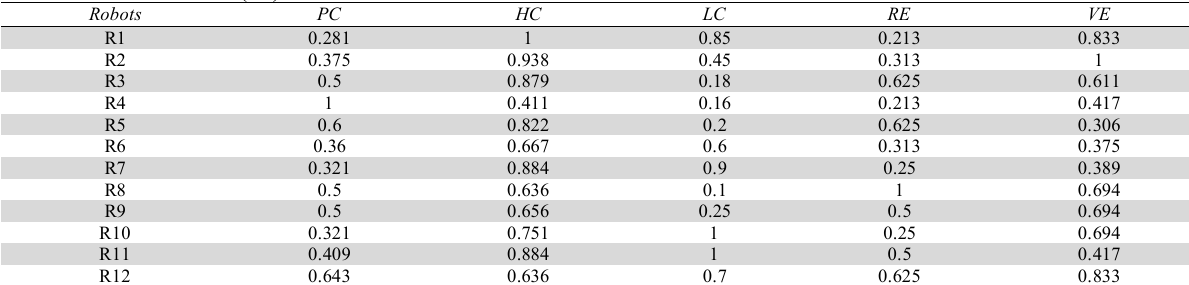
Normalized Matrix (D') Robots